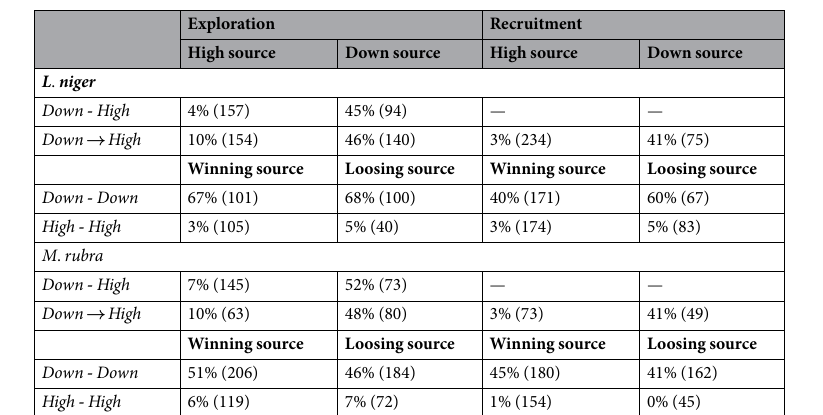
the U-turn rate was high and not significantly different between the left and right branches in L . niger , with a U-turn rate of 68% (N = 100) towards the losing source and 67% (N = 101) towards the winning one (Table 4; two-sample binomial test, P = 1). Surprisingly, the results were very similar in the recruitment phase; the U-turn rate only slightly decreased compared with the phase of exploration and remained particularly high on the losing branch (60%; N = 67) as well as on the winning one (40%; N = 171) and did not significantly differ between the winning and losing branches (Table 4; two-sample binomial test, P = 0.057). The U-turn rate for the winning branch was significantly different between the exploration and recruitment phase (67% and 40%, respectively; two-sample binomial test, P = 0.01), while no difference appeared for the losing branch (68% and 60%, respec- tively; two-sample binomial test, P = 0.53). The results were similar for M . rubra during the phase of exploration, with no significant difference in the U-turn rate towards the losing branch (46%; N = 184) and the winning one (51%; N = 206) (Table 4; two-sample binomial test, P = 0.68). During the phase of recruitment, the U-turn rate differed only slightly and not significantly (two-sample binomial test, P > 0.05 for each branch for the two phases observed): 45% (N = 180) of U-turns towards the winning source and 41% (N = 162) towards the losing one,